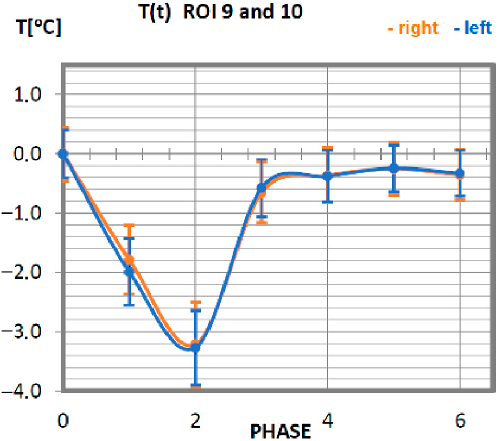
Figure 6. Temperature time (0 to 6 phase of training according to methods) changes of the greater pectoral muscles obtained before and after training using a rowing ergometer for the studied group of athletes.